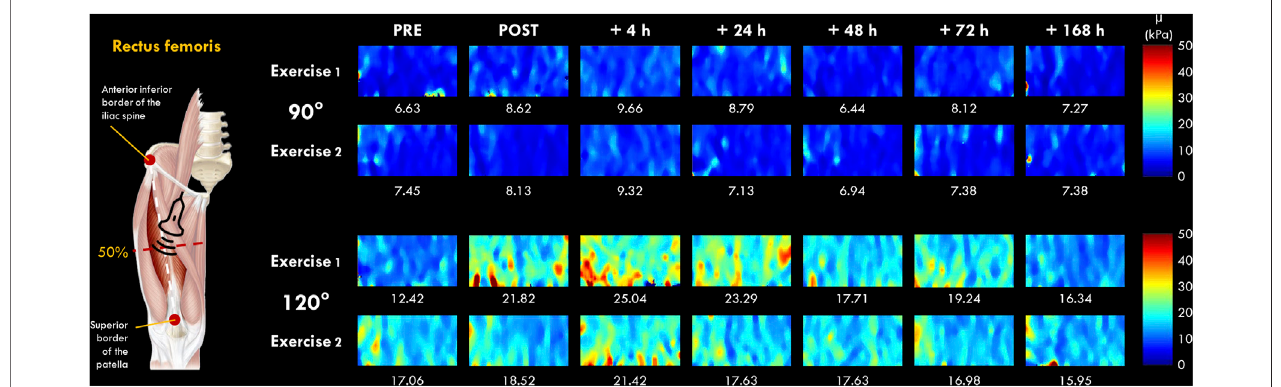
FIGURE 2 | Typical two-dimensional real-time muscle shear modulus color maps of the rectus femoris muscle obtained with a frame rate of 1 – 2 Hz and a spatial resolutionof1× 1 mm for90and 120 ° ofknee fl exion(0 ° = fullextension).Values under thecolormaps werethemean valueofthe regionofinterestplacedin themiddle of the B-mode image below the super fi cial aponeurosis within the RF muscle